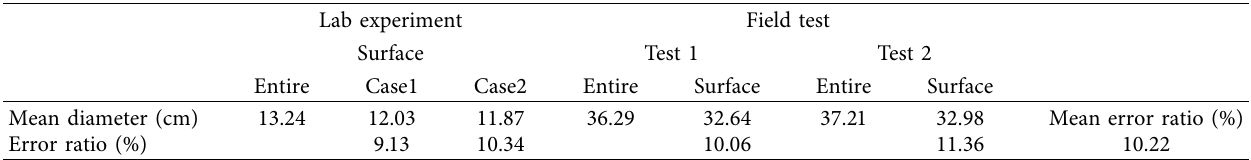
Figure 7: Possible sources of error of stacked blocks. Table 1: Error of surface rock blocks in stacked